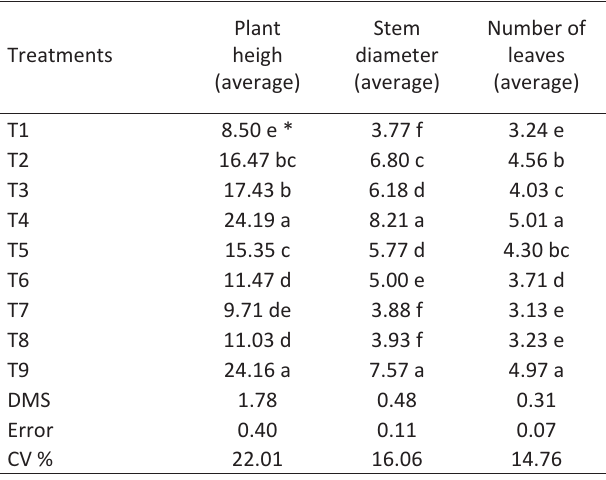
Table 3 ­ Mean values for plant height (cm), stem diameter (mm), number of leaves and nivel significative for treatments obtained in açaí seedlings ( Euterpe olera‐ ce a Mart.) grown in different combinations of substra­ tes under nursery conditions